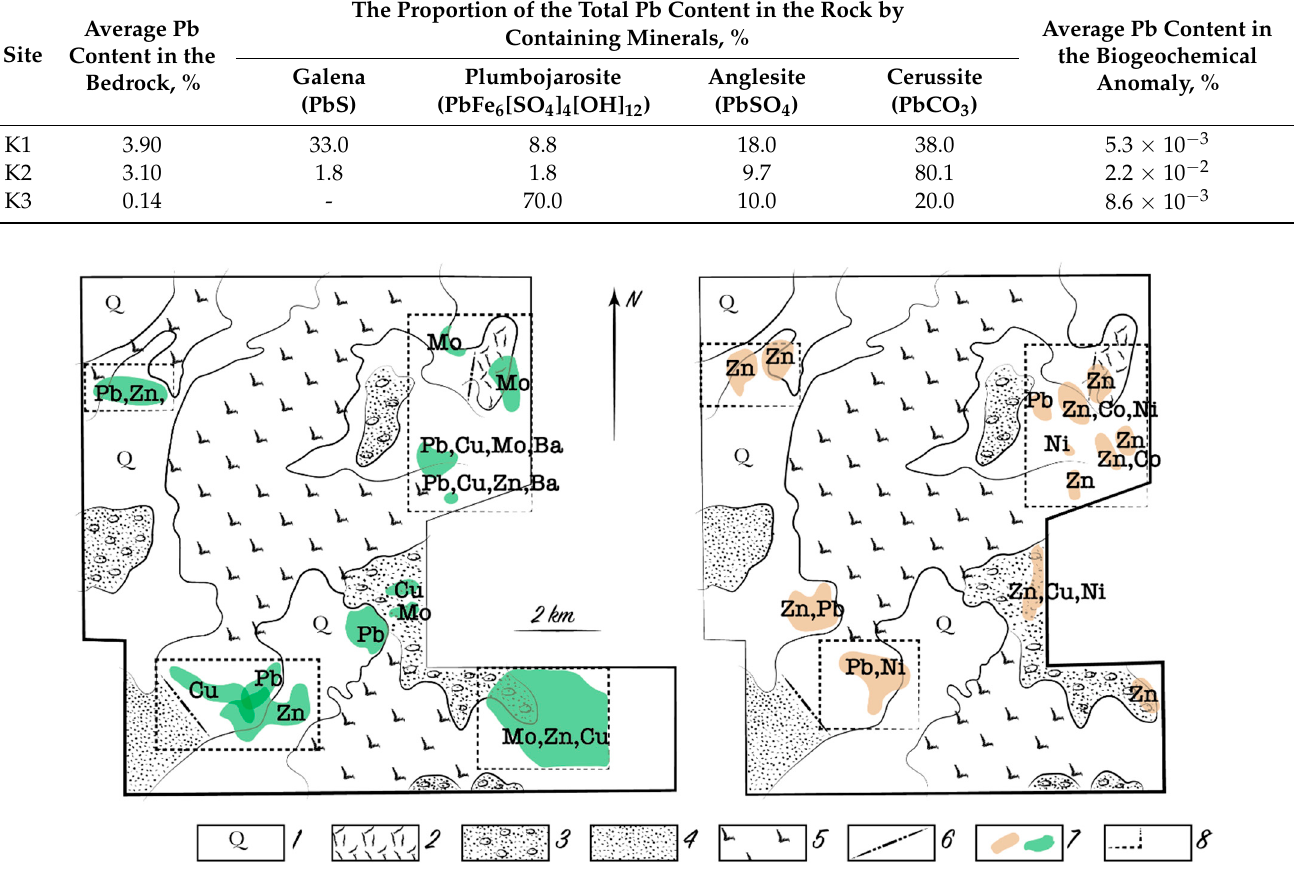
Figure 3. Biogeochemical (left) and deep lithogeochemical (right) anomalies corresponding to the Pb-Zn deposit below the 20 m thick loose deposits. Symbols: 1—recent loamy and sandy loamy sediments; 2—Lower and Middle Devonian effusive felsic rocks; 3—Paleogene quartzitic sandstones, sands, and pebbles; 4—Llandovery red-bed sandstones and gritstones; 5—Terreneuvian and Miaolingian effusive mafic igneous–sedimentary rocks; 6—disjunctive faults; 7—anomalies; 8—outlines of anomalous sites. Table 5. Metal content in the ash of saltwort ( Salsola arbuscula Pall.) in changing geomorphological and geochemical conditions of Central Kazakhstan.